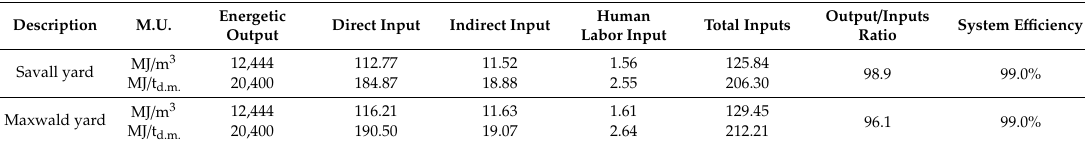
Table 12. Total energy inputs and balance in forestry logging